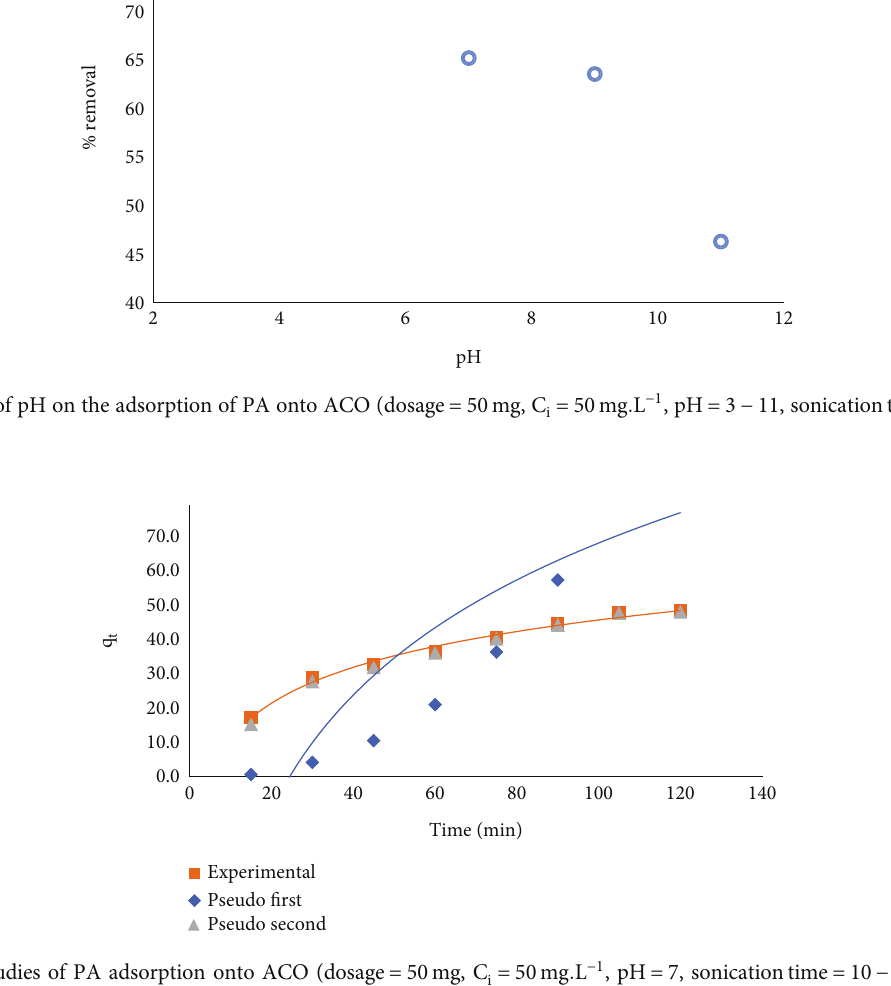
= 50mg : L − 1 , pH = 7 , sonicationtime = 10 − 120 min , and T = i